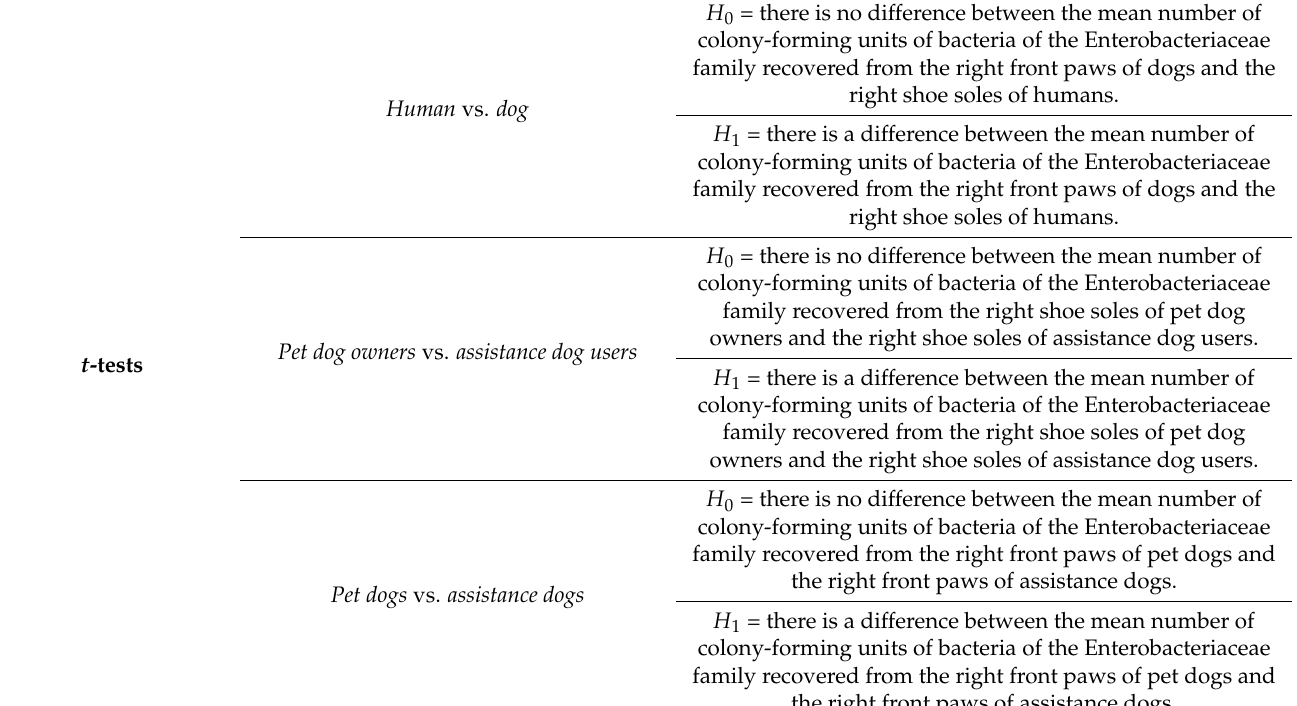
Table 1. Hypotheses of the executed t -tests and paired t -tests, for comparing the mean number of colony-forming units of bacteria of the Enterobacteriaceae family, recovered from dogs’ right front paws and humans’ right shoe soles.